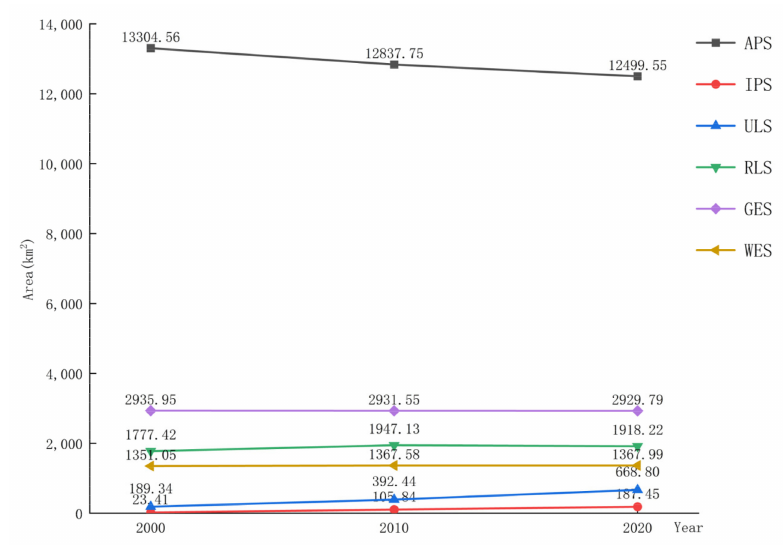
Figure 3. Area change of PLES in the Chaohu Lake Basin from 2000 to 2020.